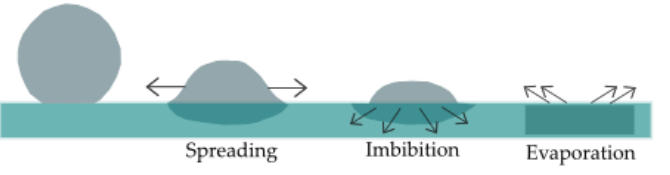
Figure 9. Spreading, imbibition and evaporation of droplet on porous substrates [49]